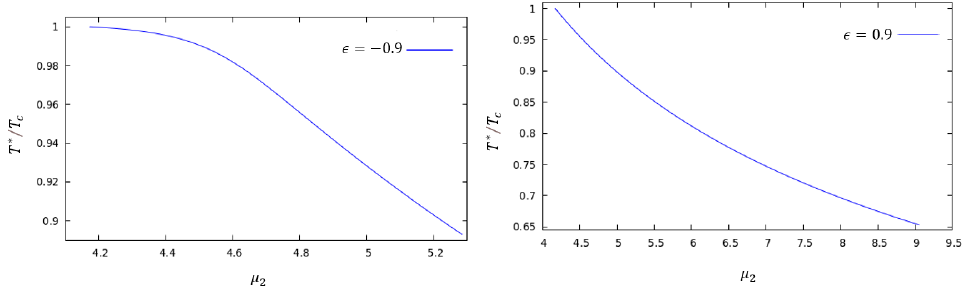
Figure 9. Unbalanced superconductors with (cid:101) = − 0.9 ( left ) and (cid:101) = 0.9 ( right ), respectively, in the ( T / T c , µ ) plane. The curves demonstrate that there is no sign of the formation of a LOFF 2